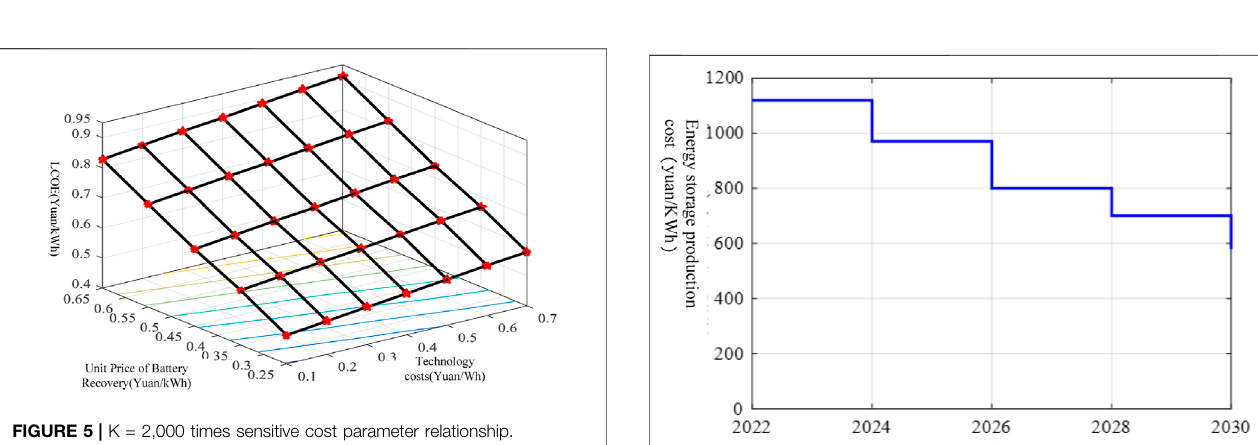
FIGURE 6 | K = 2,500 times sensitive cost parameter relationship.